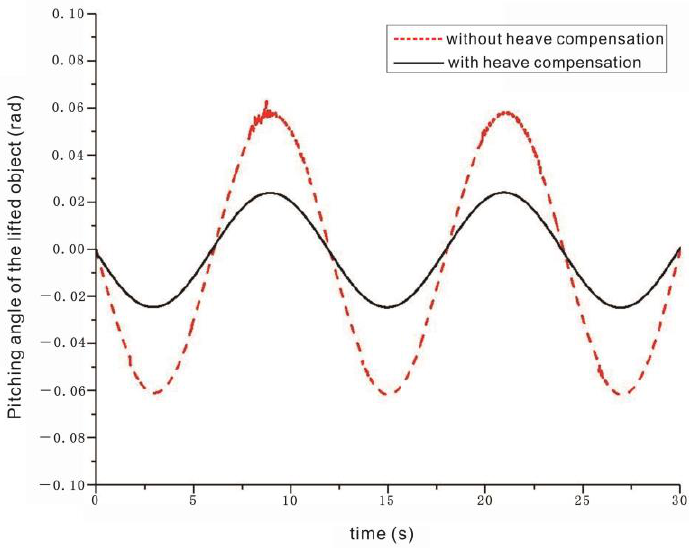
Figure 10. Longitudinal displacement of the lifted object before and after compensation.